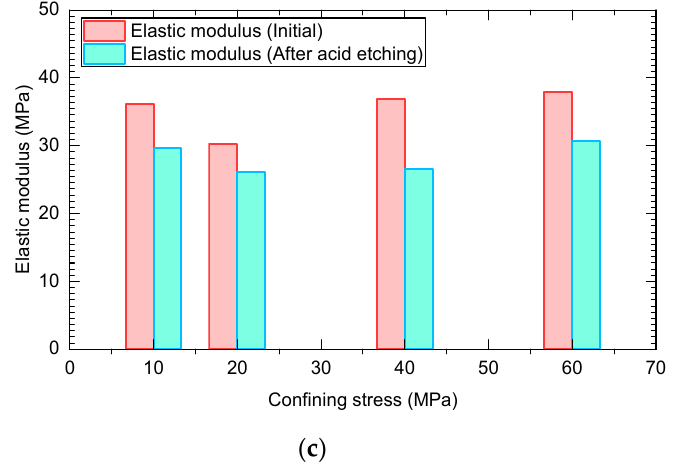
Figure 6. Effect of acid etching on the elastic modulus of rock samples with different reservoir space: ( a ) Porous, ( b ) Fracture-dissolved pore, ( c ) Fracture-pore.